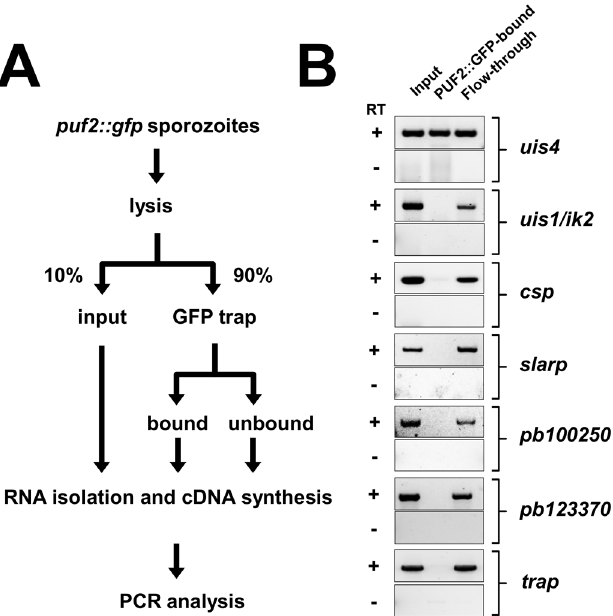
Fig 2. RNA immunoprecipitation of PUF2::GFP from puf2 :: gfp salivary gland sporozoites from day 21 post mosquito infection reveals binding of uis4 by PUF2::GFP. (A) Schematic of the GFP-Trap_A Kit (Chromotek) IP protocol used. ( B) RT-PCR performed on RNA isolated from the input and IP eluates as outlined in A to verify the presence or absence of uis4 and control genes in IP eluates. The material used for the input RT-PCR represents 6.7% of bound as well as unbound samples. RT+ and RT- indicate cDNA synthesis set-up in the presence (+) or absence (-) of Reverse